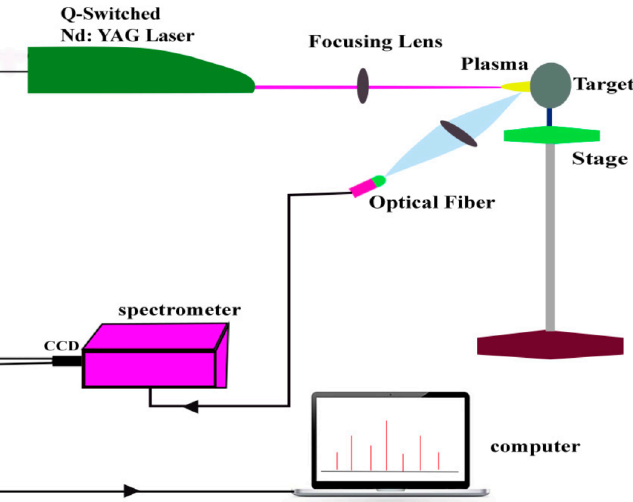
Figure 2. Schematic arrangement of the laser-induced breakdown spectroscopy (LIBS) detection system employed to perform the